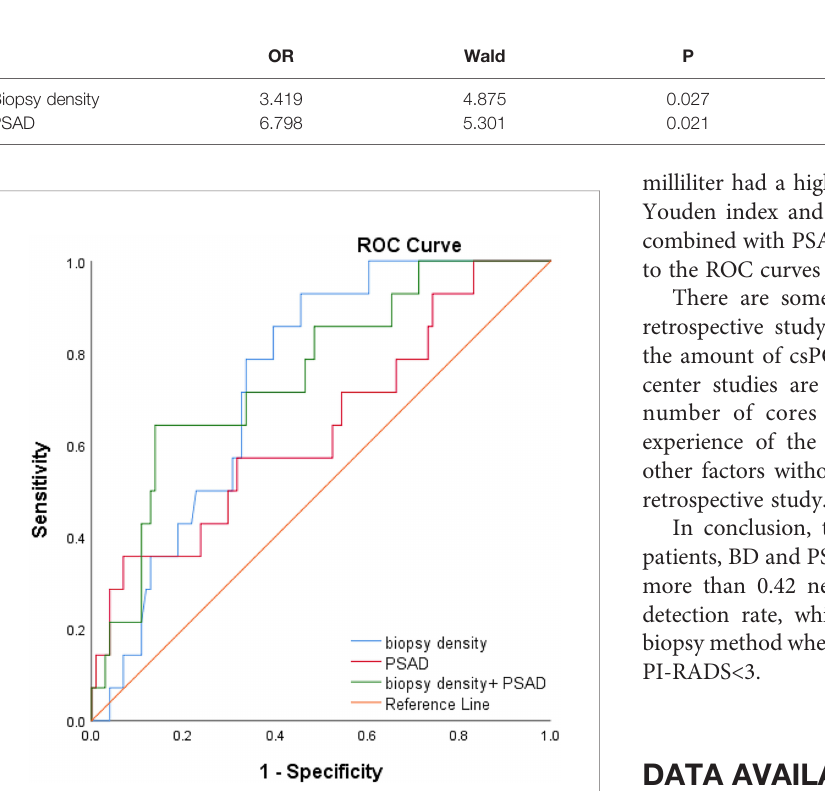
FIGURE 4 | ROC curve of positive biopsy using age, PSAD, BD, and age +BD+PSAD.